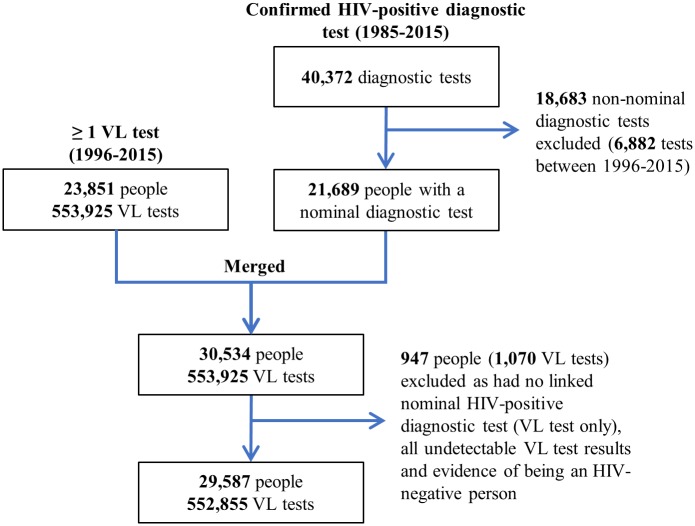
Flow diagram for the creation of the Ontario HIV Laboratory Cohort from the Public Health Ontario Laboratory HIV datamart.Non-nominal forms of testing include the use of coded or completely anonymous identifiers. Evidence of being an HIV-negative person = record of a nominal HIV-negative diagnostic test after, on the same day as, or within 30 days before last undetectable viral load test. VL = viral load.